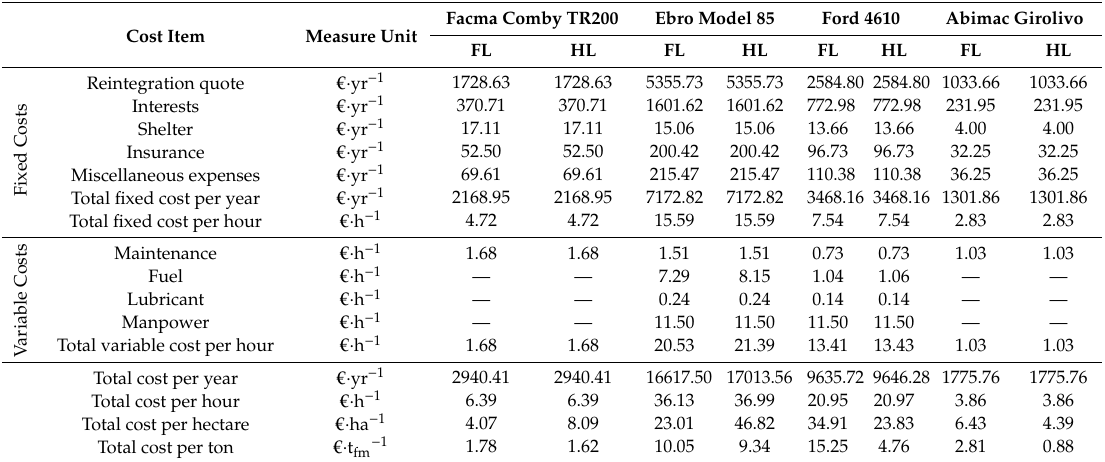
Table 5. Details of the fixed and variable costs for each machine used in both experimental fields.